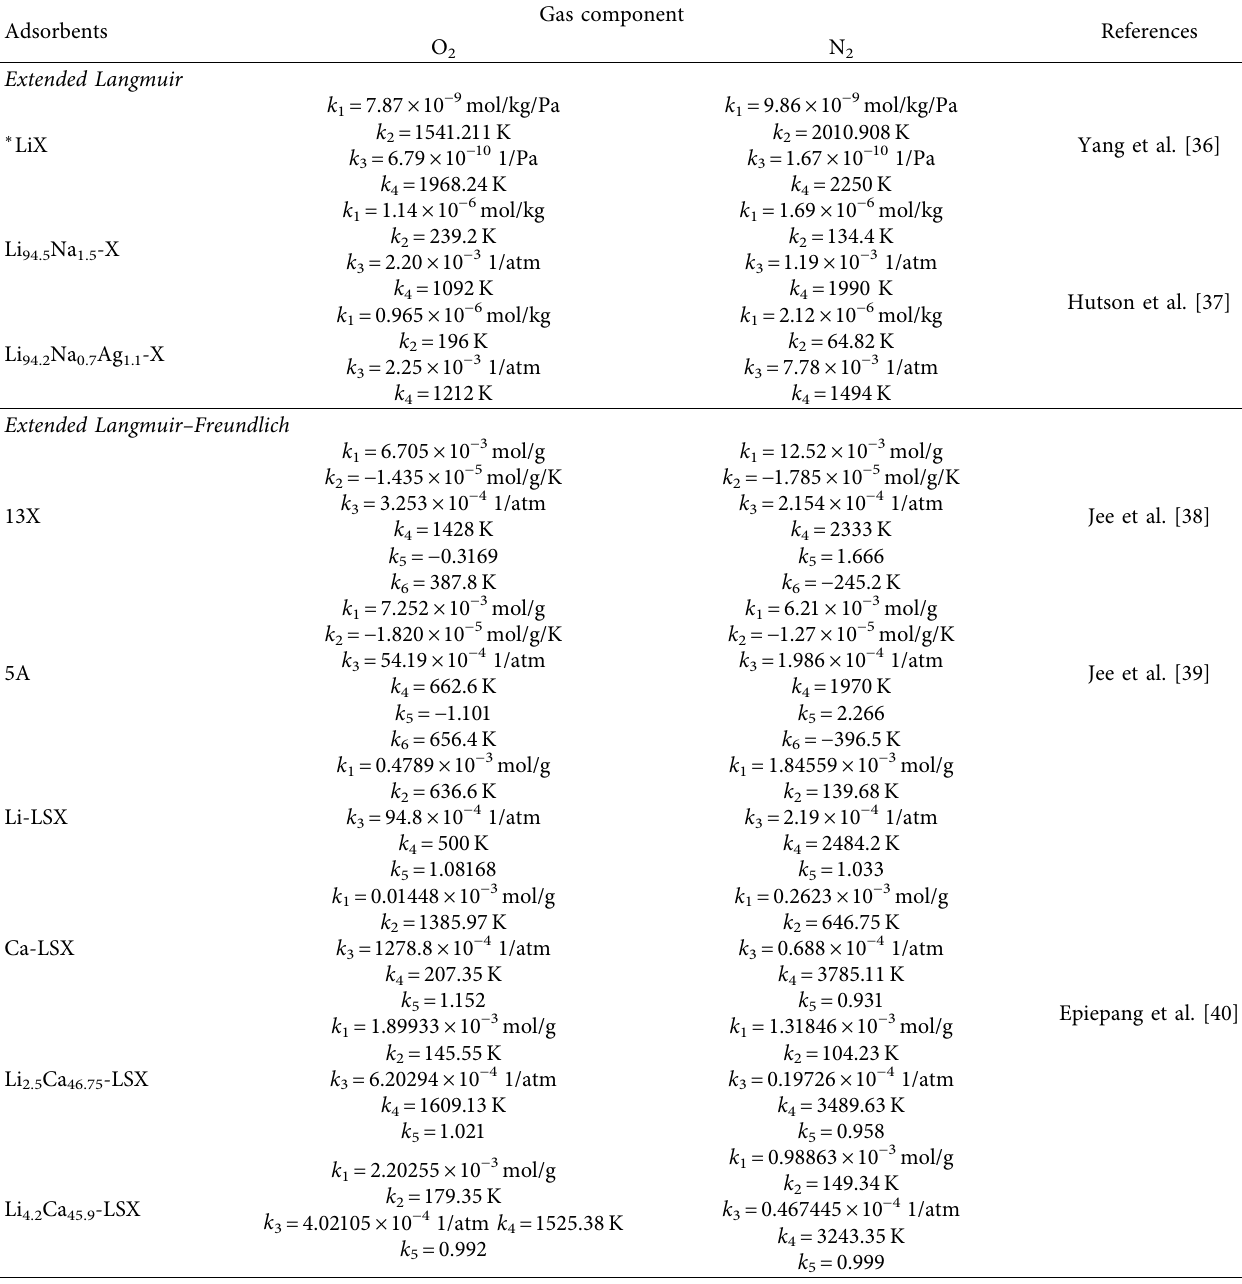
Table 1: Te adsorption isotherms’ parameters of various zeolites for O Langmuir–Freundlich